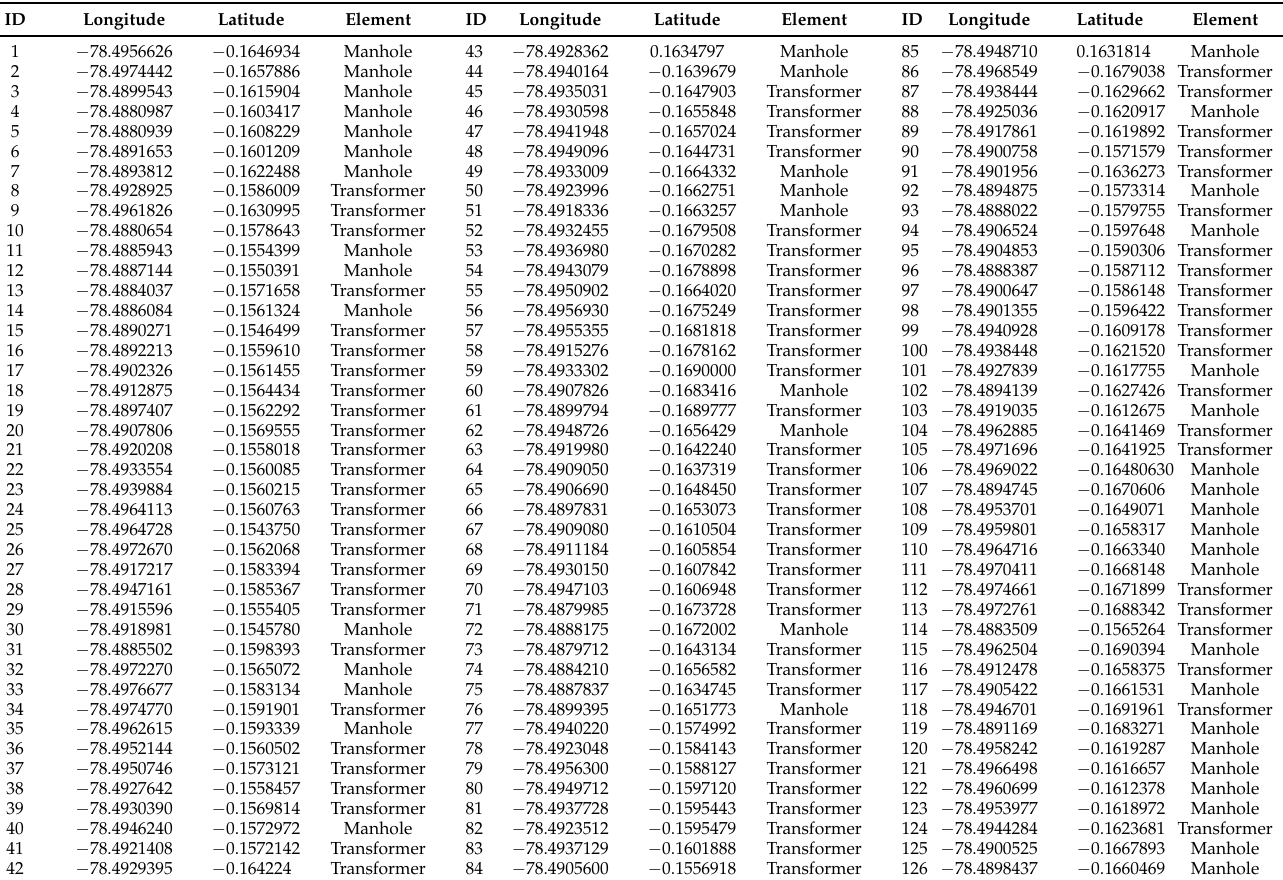
Table 6. Distribution of transformers and manhole in the grid